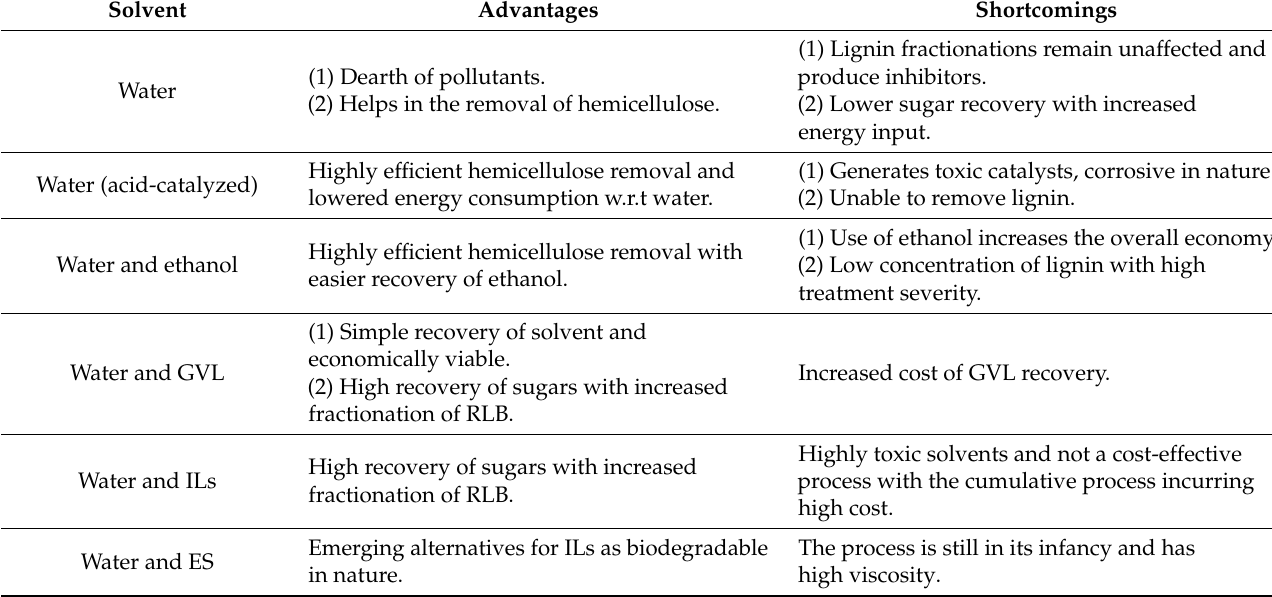
Table 2. Advantages and shortcomings of solvent systems for HT treatments of